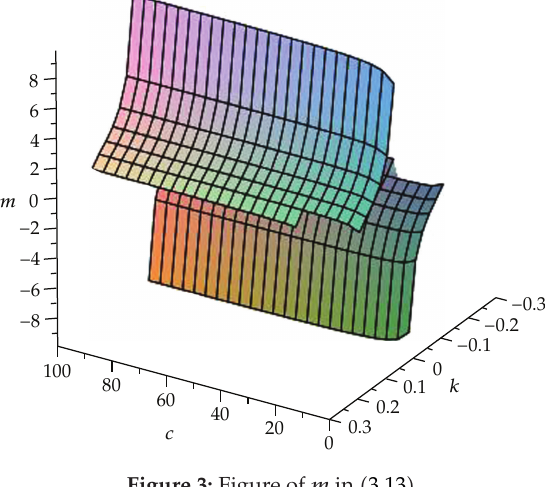
Figure 3: Figure of m in (cid:3) 3.13 (cid:4)